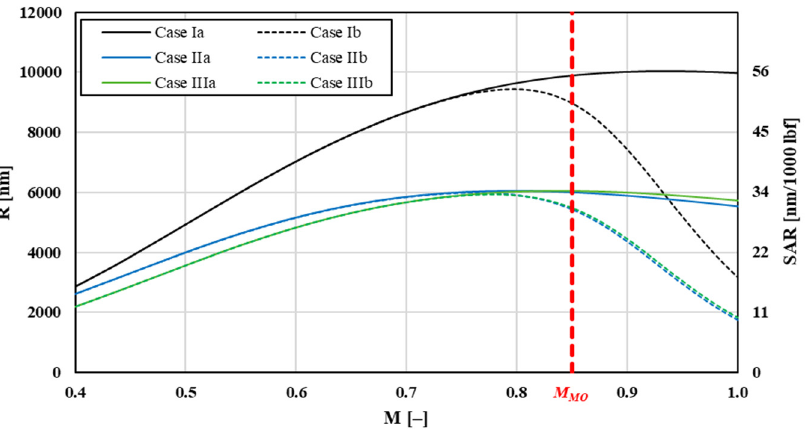
Figure 3. Range and SAR of the fictional T-category high-subsonic jet airplane for three different fuel laws, with each model including and excluding transonic wave drag C Dw